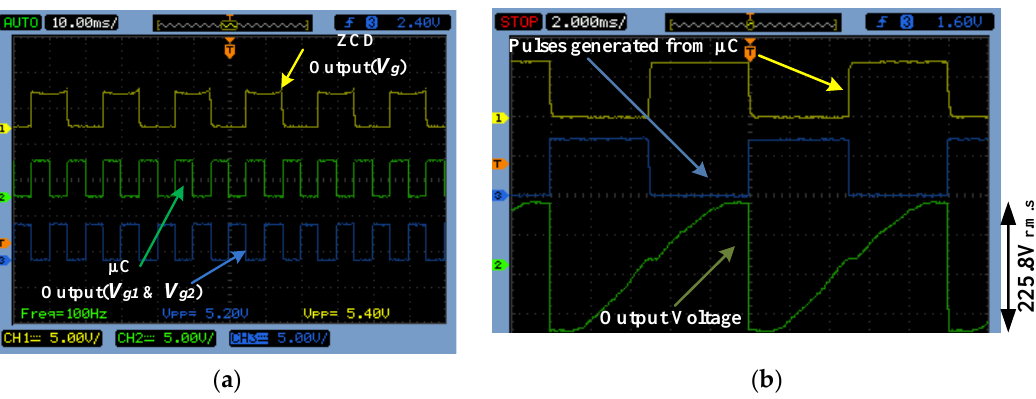
Figure 14. ( a ) Experimental results of ZCD and microcontroller output. (Scale: 5 V/div) and ( b ) experimental validation of synchronized output w.r.t. pulses. (Scale: output voltage, 75 V/div and Time, 10 ms/div).